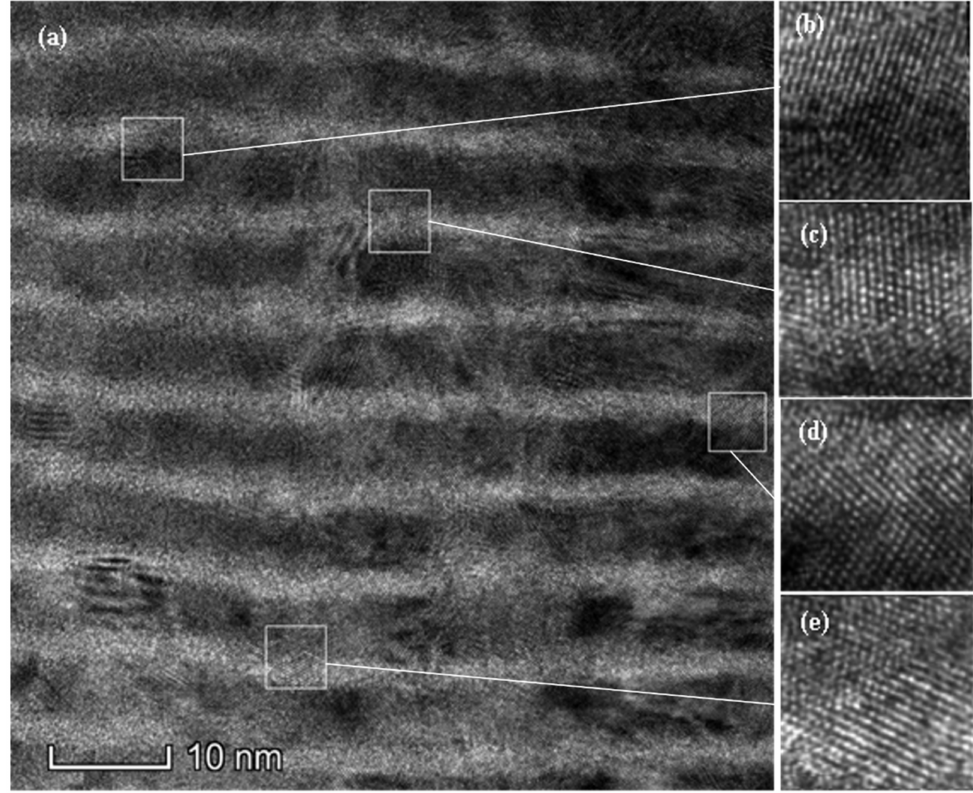
Figure 8. ( a ) High-resolution TEM image of Mo/VC multilayers with η Mo/VC = 8:2, ( b – e ) Coherent interfaces